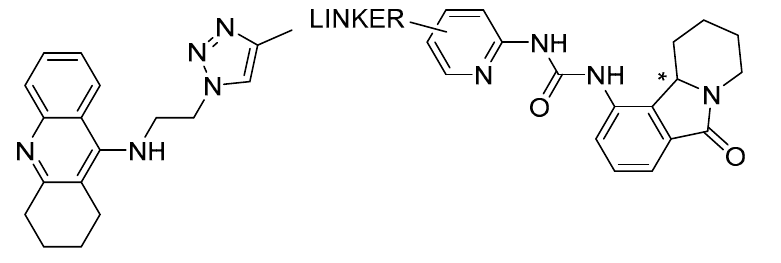
Figure 7. Tacrine and valmerin hybrids from [100].